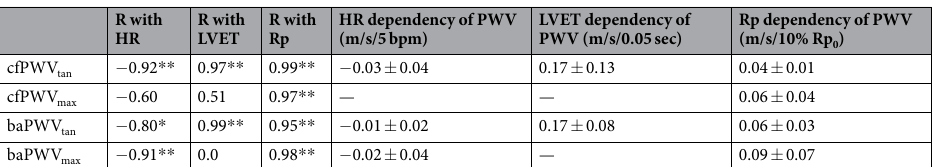
Table 1. Correlation coefficients between PWV and HR and LVET, and their dependency of PWV (R represents correlation coefficient). * and ** present P < 0.05 and P < 0.01,